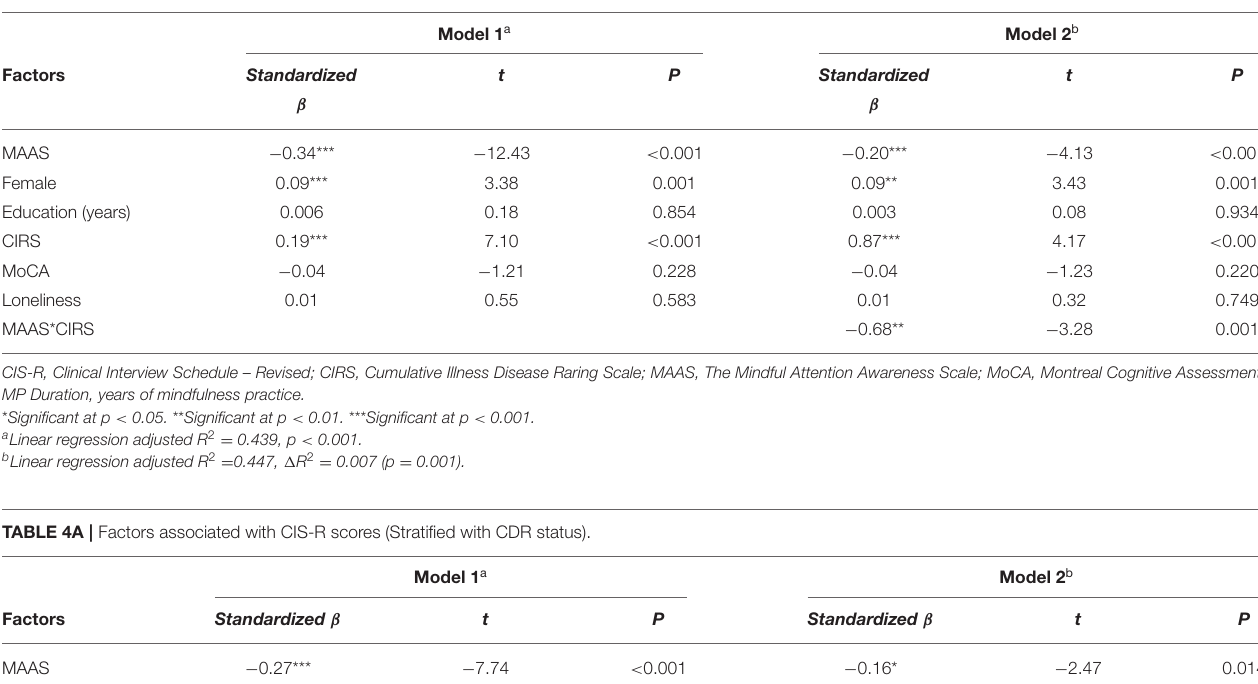
TABLE 3 | Factors associated with CIS-R scores (All participants).